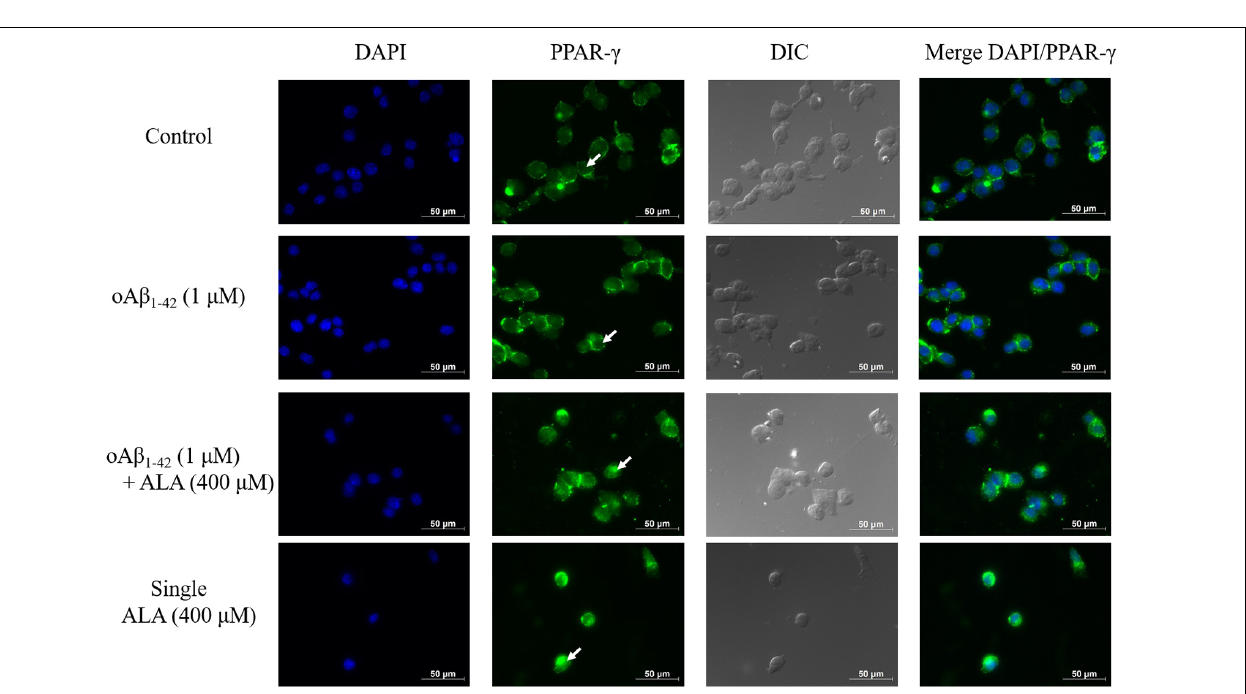
FIGURE 6 | Blocking effect of CD36 antibody on ALA-enhanced phagocytosis ability of FAM-oA β 1 − 42 in BV-2 mouse microglial cells. BV-2 cells were pretreated with or without ALA (400 µ M) in the presence of a CD36 antibody or isotype control for 30 min, followed by FAM-oA β 1 − 42 treatment for 24 h. Mean fluorescence intensity was detected using a flow cytometer. * p < 0.05 vs. the control group and # p < 0.05 vs. the ALA group.